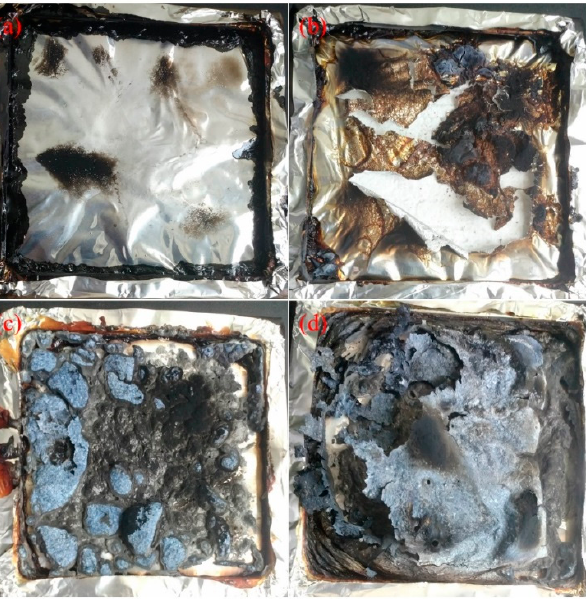
Figure 4. The digital photographs of the residue after the CONE test: ( a ) EVA, ( b ) EVA/PCS, ( c ) EVA/MH, and ( d ) EVA/MH/PCS.